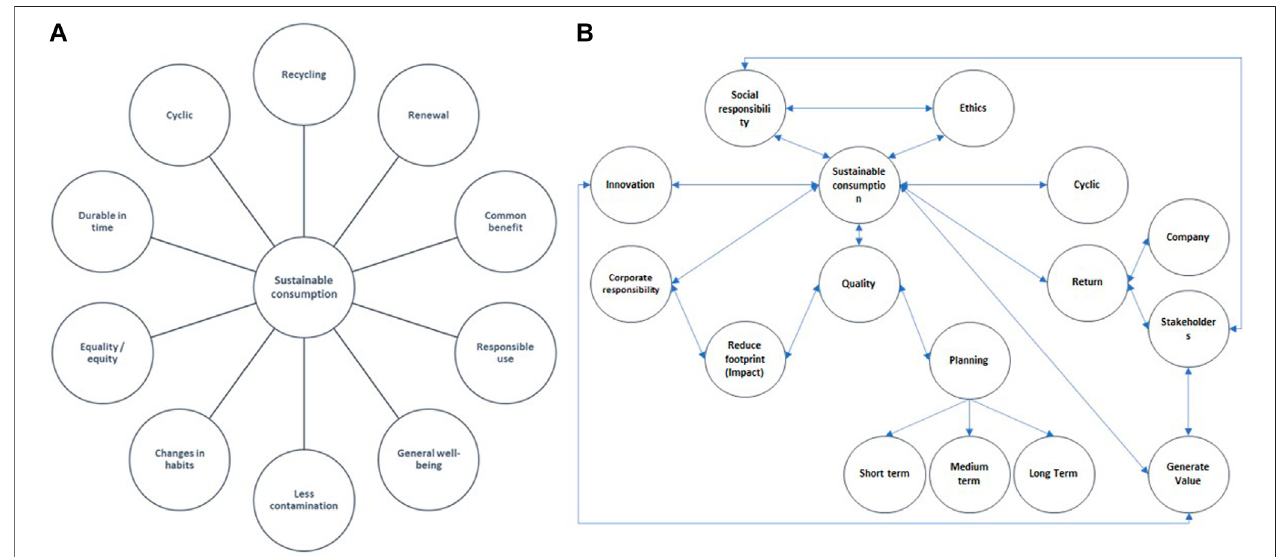
FIGURE 2 | Example of the (A) before and (B) after construction made by a